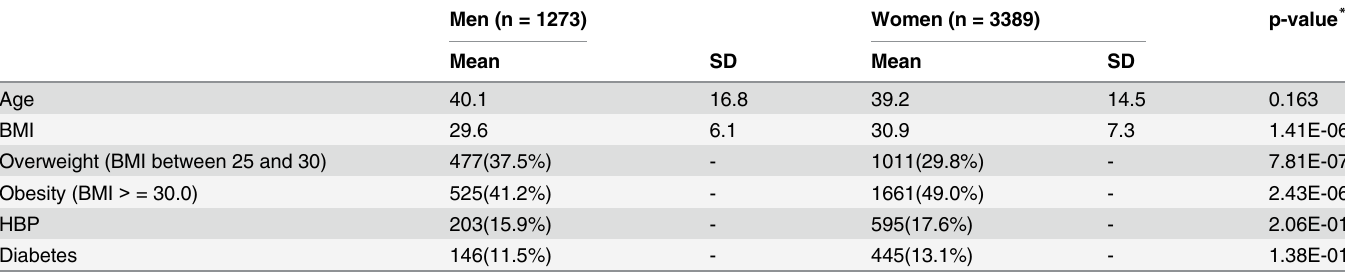
Table 1. Demographic characteristics of